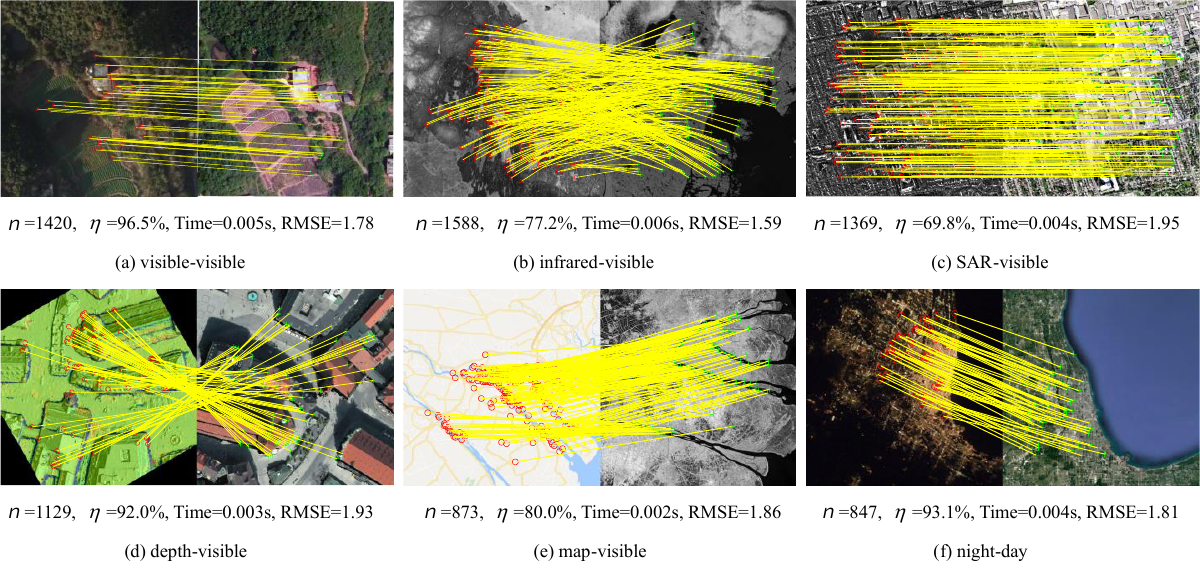
Figure 6. Our matching results on six different types of multimodal image pairs. n is the size of initial correspondence set, η is the outlier rate of initial correspondences. Each line represents a feature correspondence.